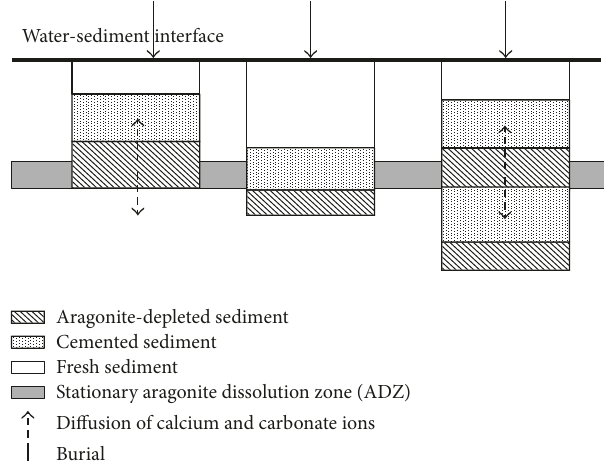
Figure 2: Schematic representation of Munnecke et al. [27] and B¨ohm et al.’s [28] conceptual model for the generation of self- organized rhythmites. Left diagram: as fresh sediment is buried, aragonite dissolution occurs in a bacterially active ADZ. Carbonate and calcium ions are transported by diffusion and advection and the sediment immediately above the ADZ is cemented by calcite (dominantly) and aragonite precipitation. Center diagram: as the sediment is buried, the cemented zone passes the ADZ with much- reduced aragonite dissolution rates. Right diagram: as the cemented zone gets buried below the ADZ, fresh sediment is made available again to strong aragonite dissolution, and the cycle repeats itself again. The result is a sequence of cemented sediments (limestone- rich) alternating with carbonate-depleted sections